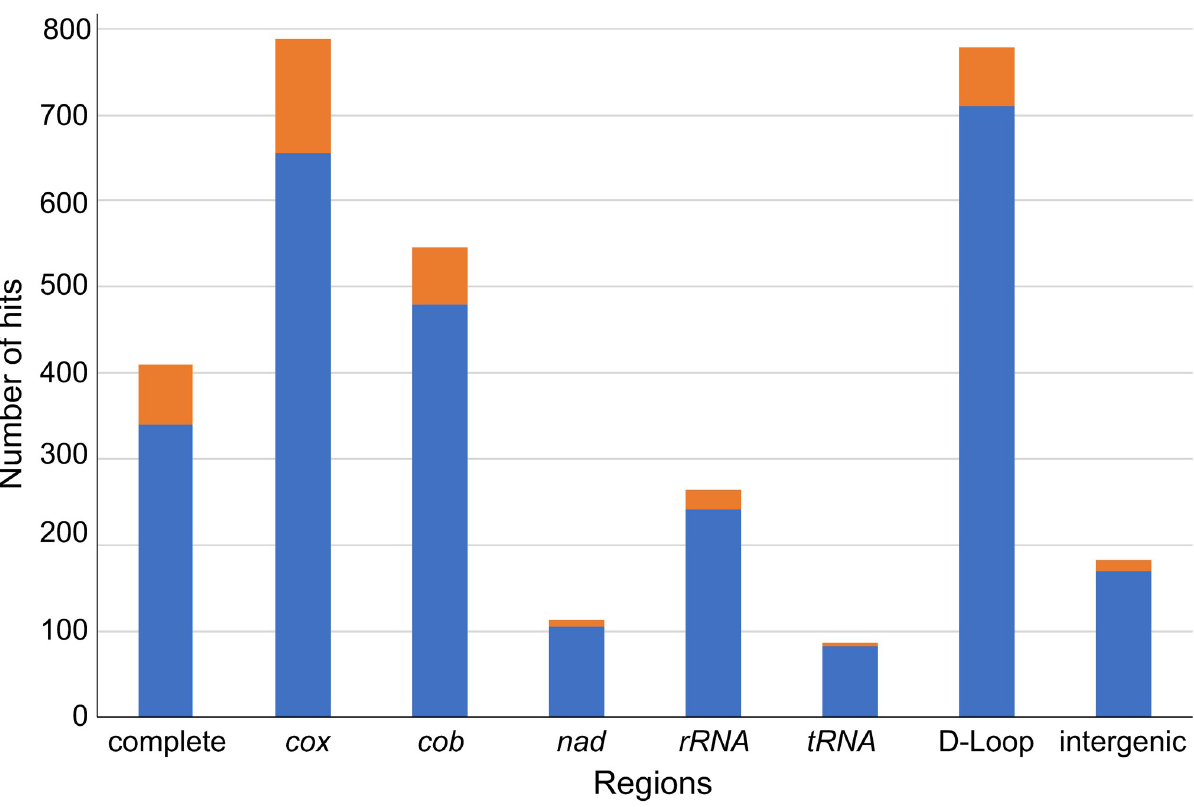
Fig 1. Number of literature hits by a PubMed search using various keywords related to different regions on mtDNA as of July 2021. The number of publications dated 2018 to 2021 are shown in orange, and the ones older than this period are shown in blue. Hit numbers for the intergenic region (IGR) do not include those for D-loop. The gene name abbreviations are as follows: Cytochrome c oxidase subunits, cox ; cytochrome b, cob; NADH dehydrogenase subunit, nad .